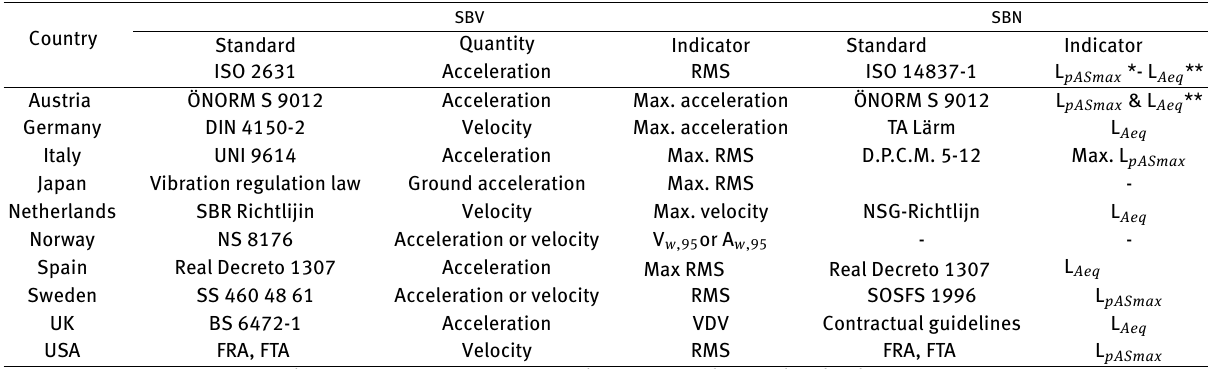
Table 1: SBV/SBN measurement according to international standards (adopted from [27]